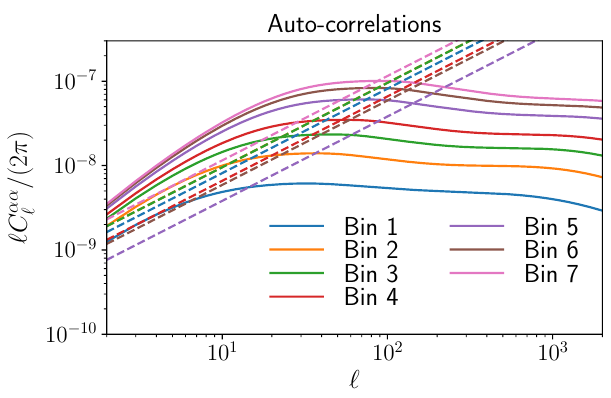
and the noise Figure 9. Theory angular power spectrum for the fiducial cos- (cid:96) mological parameters after the KL transform as a function of the multipole (cid:96) . The first eigenvalue has the darkest colour and con- tains most of the information, while the last eigenvalue has the lightest colour and is completely subdominant.